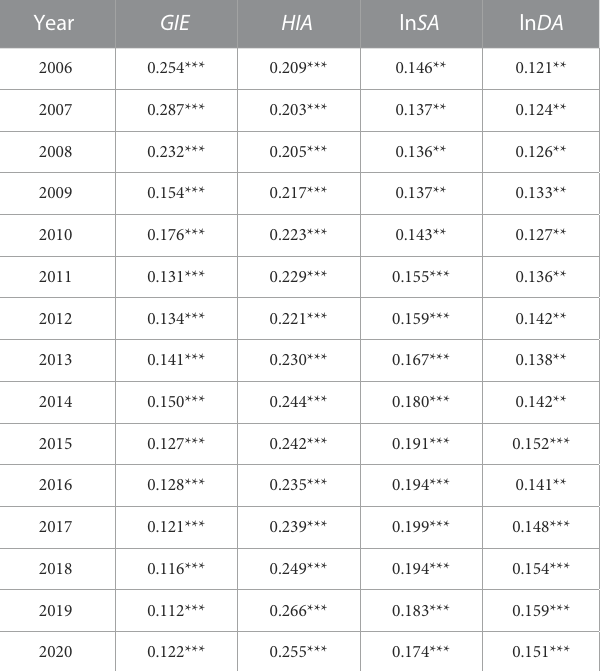
TABLE 4 Spatial autocorrelation test for